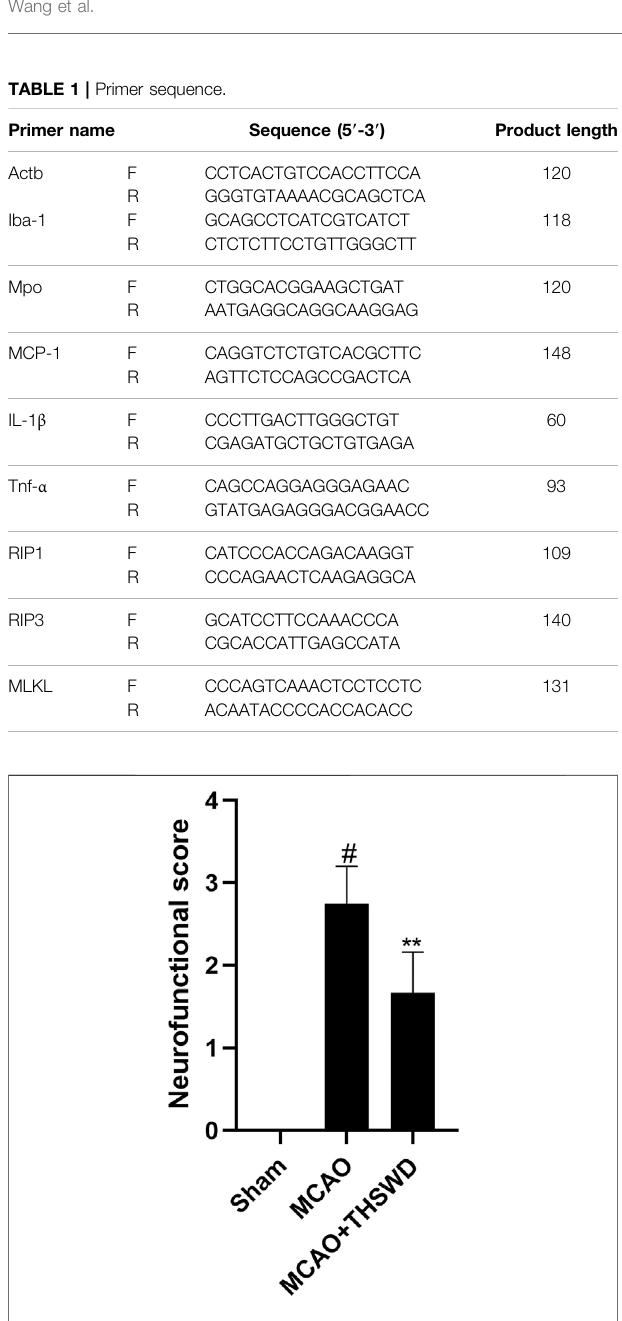
FIGURE 1 | Neurological score. Notes: # P < 0.01 vs Sham operation group; ** P < 0.05 vs MCAO group.